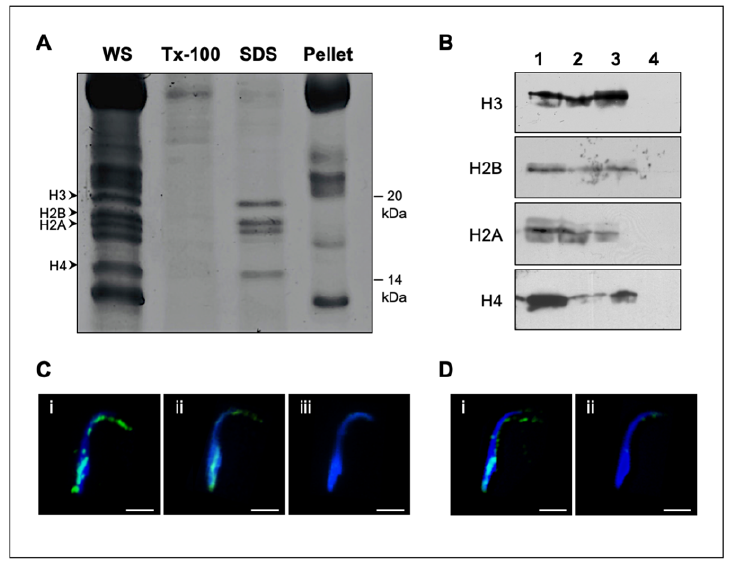
Figure 2. Histone extractability and localization in rat spermatozoa: ( A ) Coomassie gel profile of the four histones present within whole sperm (WS), their resistance to extractability with 2% Triton-100 (Tx-100), their extractability with 2% SDS (SDS), and the remaining unextracted bands within the pellet (Pellet); ( B ) the immunoreactivity of affinity purified histone antibodies against H3, H2B, H2A, and H4 with calf thymus histones (lane 1), rat whole sperm (lane 2), 2% SDS extract of rat whole sperm (lane 3), and the sperm pellet after SDS extraction (lane 4); ( C ) spermatozoa probed with an anti-pan histone antibody that reacts to all core histones (i), an H3 affinity-purified histone (ii), and Rabbit IgG control (iii), all merged with DAPI nuclear labeling; ( D ) TX-100 (i) and SDS (ii)-extracted spermatozoa probed with anti-H3 antibody and merged with DAPI labeling. White bar = 5 μ m.